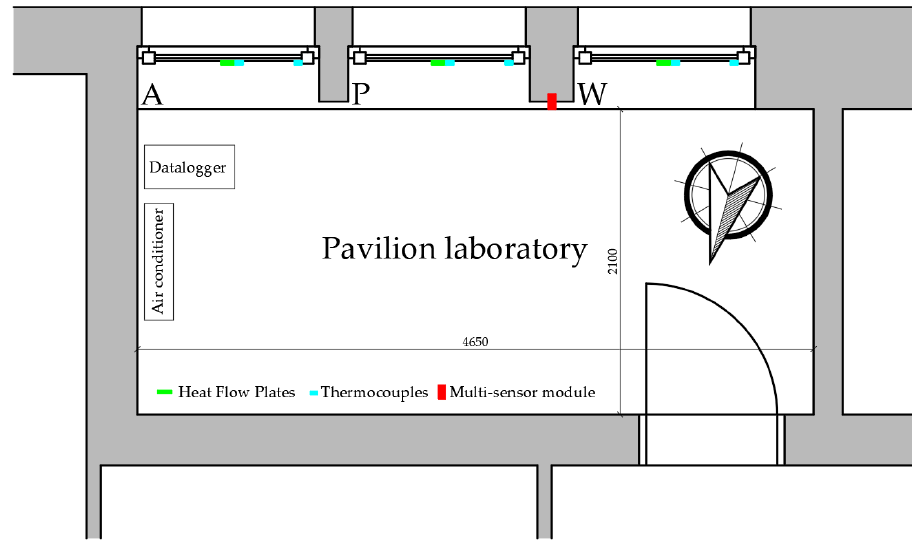
Figure 2. Window constructions were installed in the pavilion laboratory.